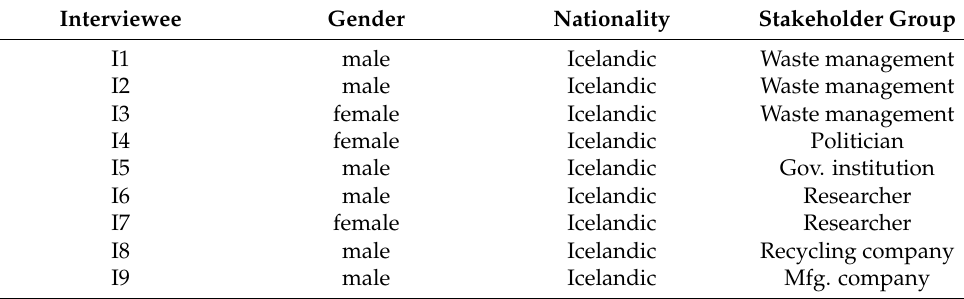
Table 1. Demographics of interviewees participating in this